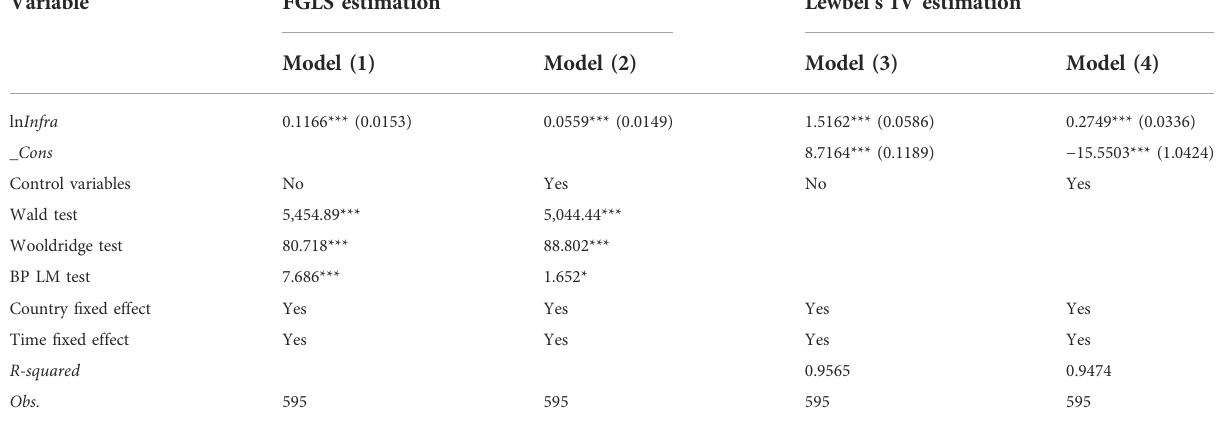
TABLE 5 Robust results of alternative regression methods.